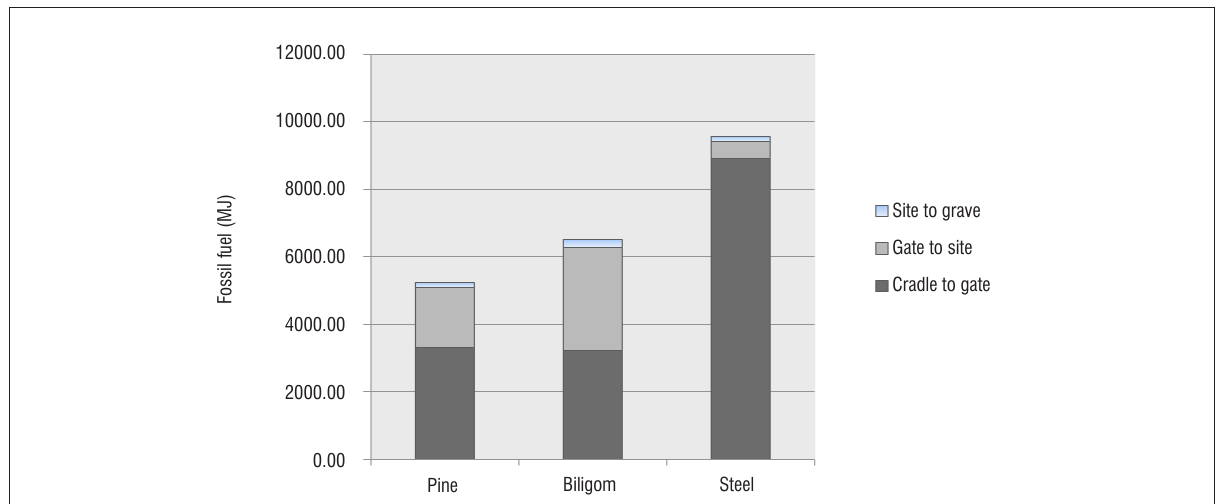
Figure 4: Depletion of abiotic resources/ fossil fuel (MJ) per life-cycle stage for the 42-m 2 roof